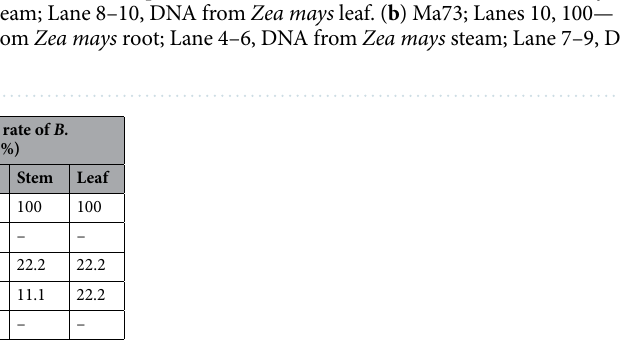
Table 4. Recovery rate of B. bassiana and M. anisopliae from maize tissues.